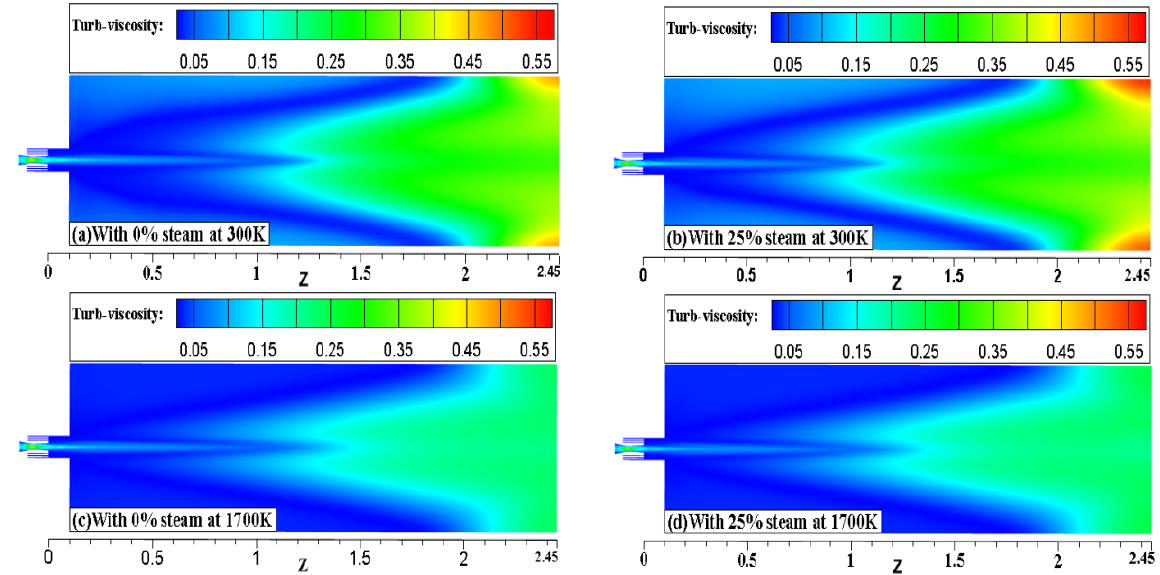
Figure 14. Axial cross-sectional distribution of the turbulent viscosity of the coherent supersonic jet at different temperatures and different water contents: ( a ) 0% steam and 100% oxygen at 300 K; ( b ) 25% steam and 75% oxygen at 300 K; ( c ) 0% steam and 100% oxygen at 1700 K; and ( d ) 25% steam and 75% oxygen at 1700 K.